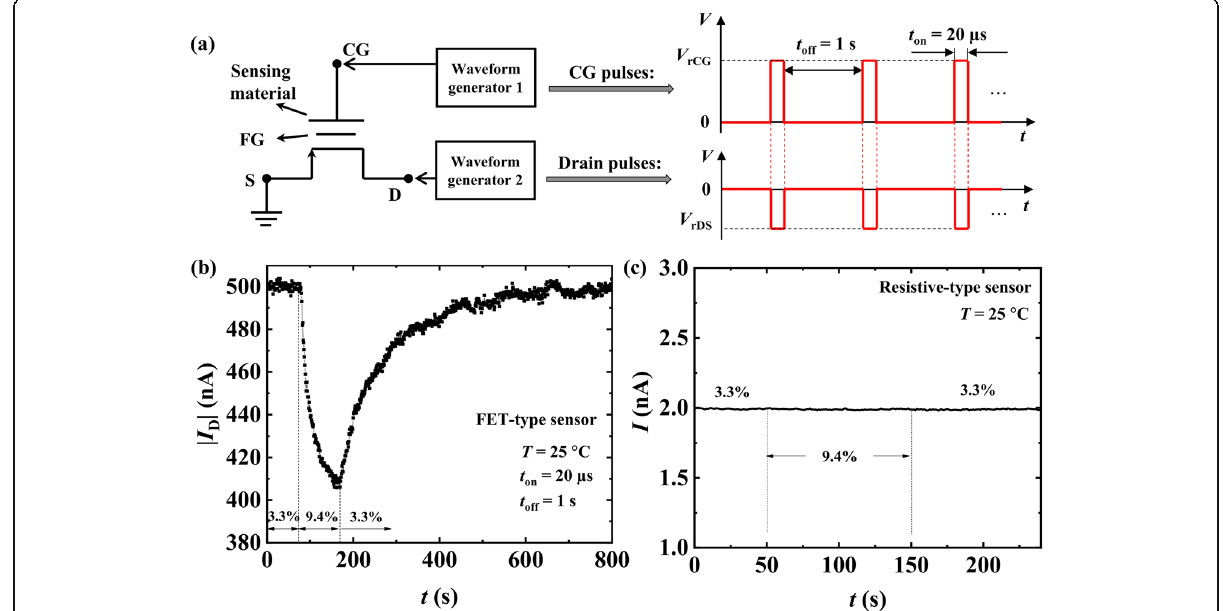
Fig. 4 Sensing performance of two types of sensors for 9.4% RH. a Schematic of the FET-type sensor and the pulse scheme used for the measurement of the FET-type sensor in this work. b | I D | of FET-type sensor based on p MOSFET decreased obviously as RH increased from 3.3 to 9.4%. The sensor was blown with humid air for 100 s from about 70 to 170 s. c DC transient measurement of the resistive-type sensor and no response was observed from the resistive-type sensor for 9.4%